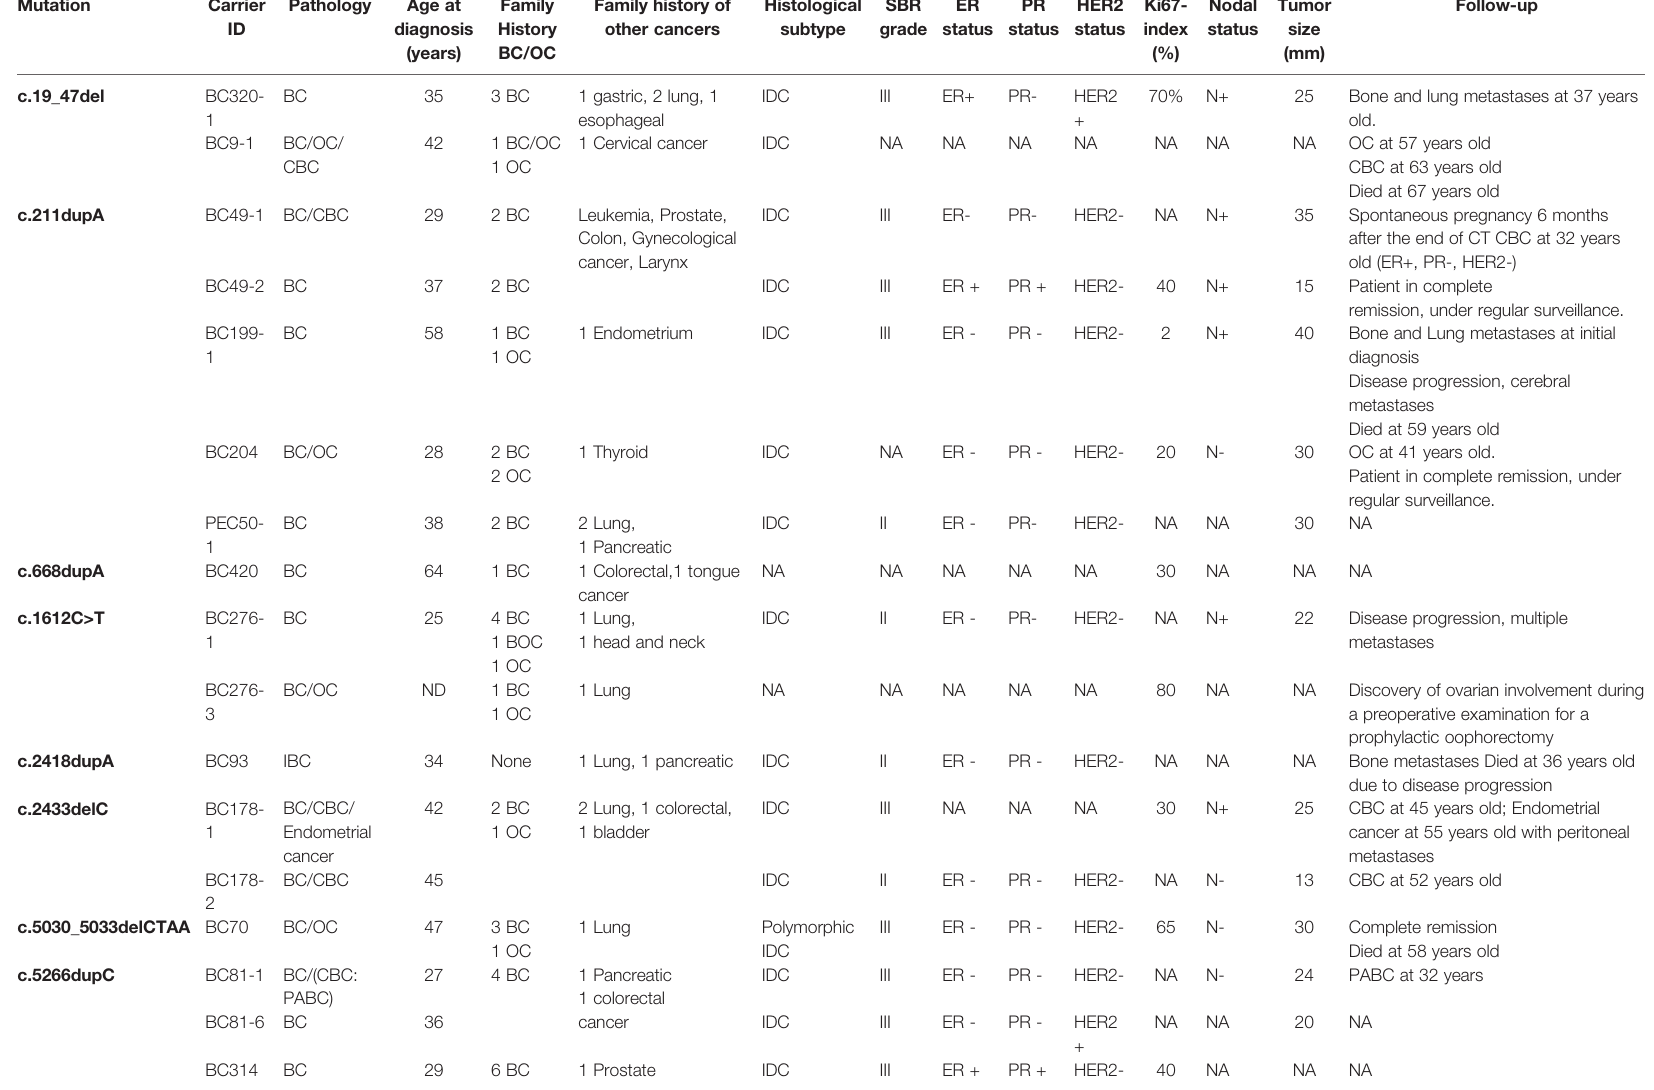
TABLE 2 | Clinicopathological features of BRCA1